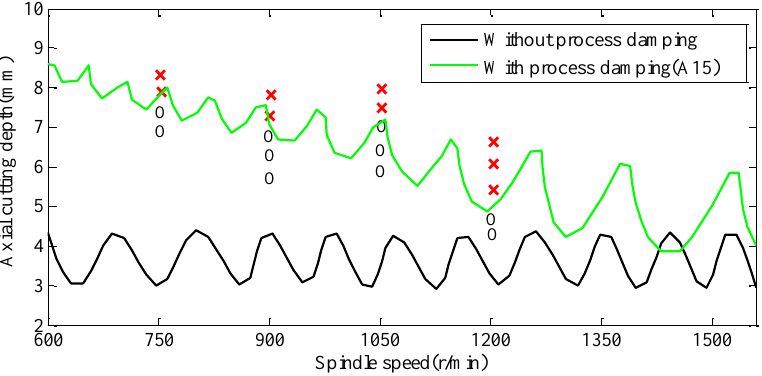
Figure 9. SLD, X-experimental stable, O-experimental unstable.